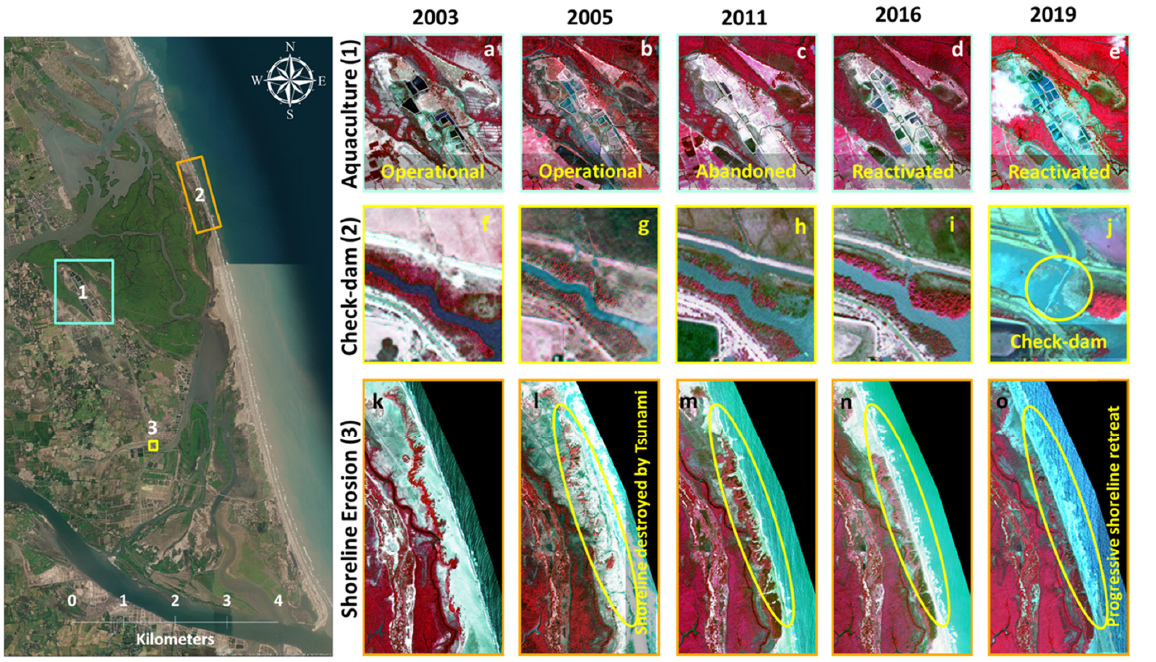
Figure 8. Changes observed in the land-cover of Pichavaram mangroves and the surrounding areas from the visual inspection of the VHRS images (image excerpts on the right ) in combination with a 2016 color-composite image provided by Google Earth ( left ). Aquaculture expansion in the vicinity of the mangrove forest ( a – e ), check-dam construction in freshwater channel to Pichavaram ( f – j ), and progressive shoreline erosion ( k – o ) can be easily identified and